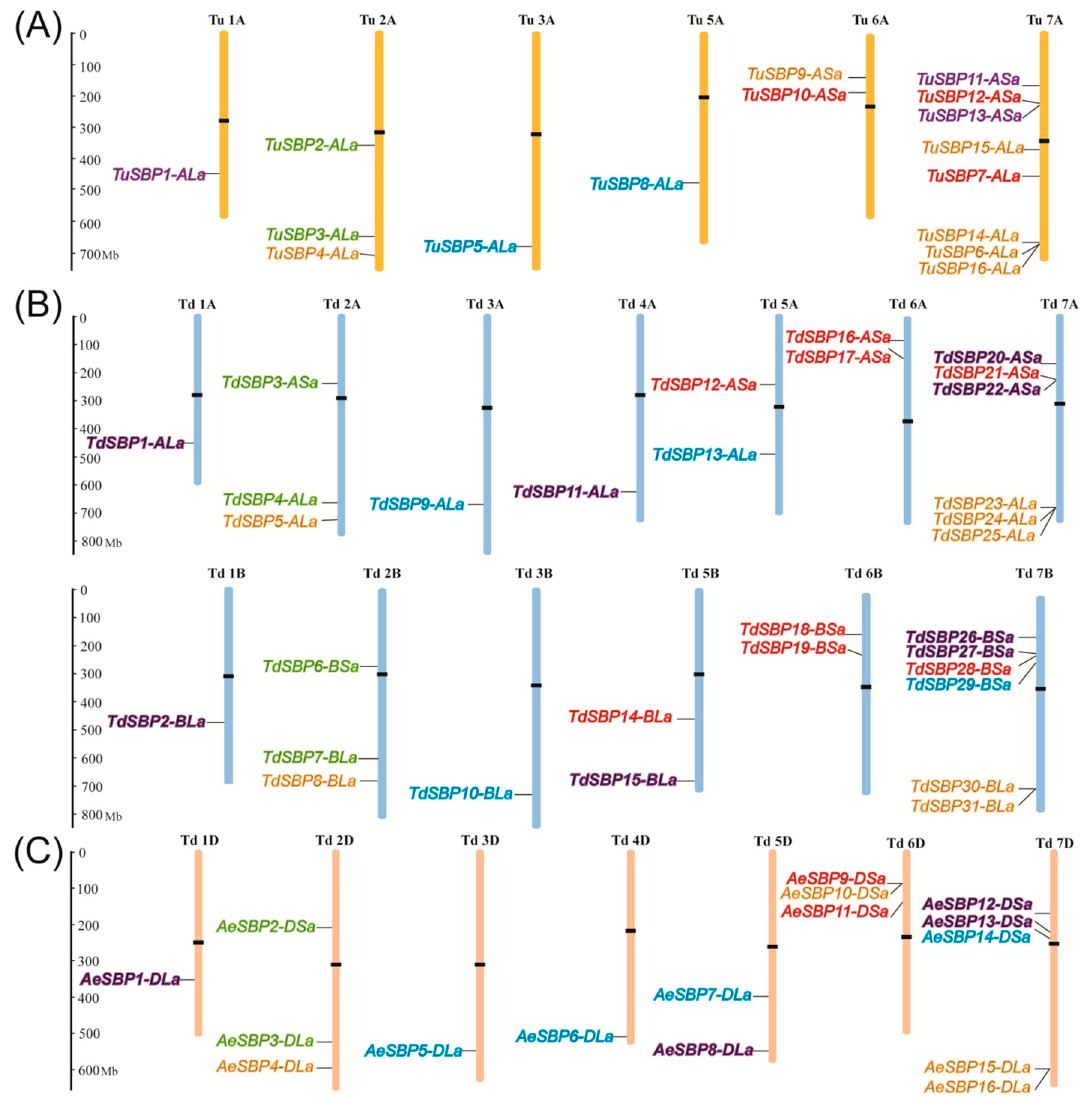
Figure 4. Chromosomal localization of the TuSBPs , TdSBPs , and AeSBPs : ( A ) chromosomal locations of TuSBP genes; ( B ) chromosomal locations of TdSBP genes; and ( C ) chromosomal locations of AeSBP genes. Colored columns represent chromosomes and the black dots represent the centromere. Di ff erent groups of SBPs are represented in di ff erent colors. Blue represents Group I, purple represents Group II, orange represents Group III, green represents Group IV, and red represents Group V. In addition, Chr represents Chromosome.